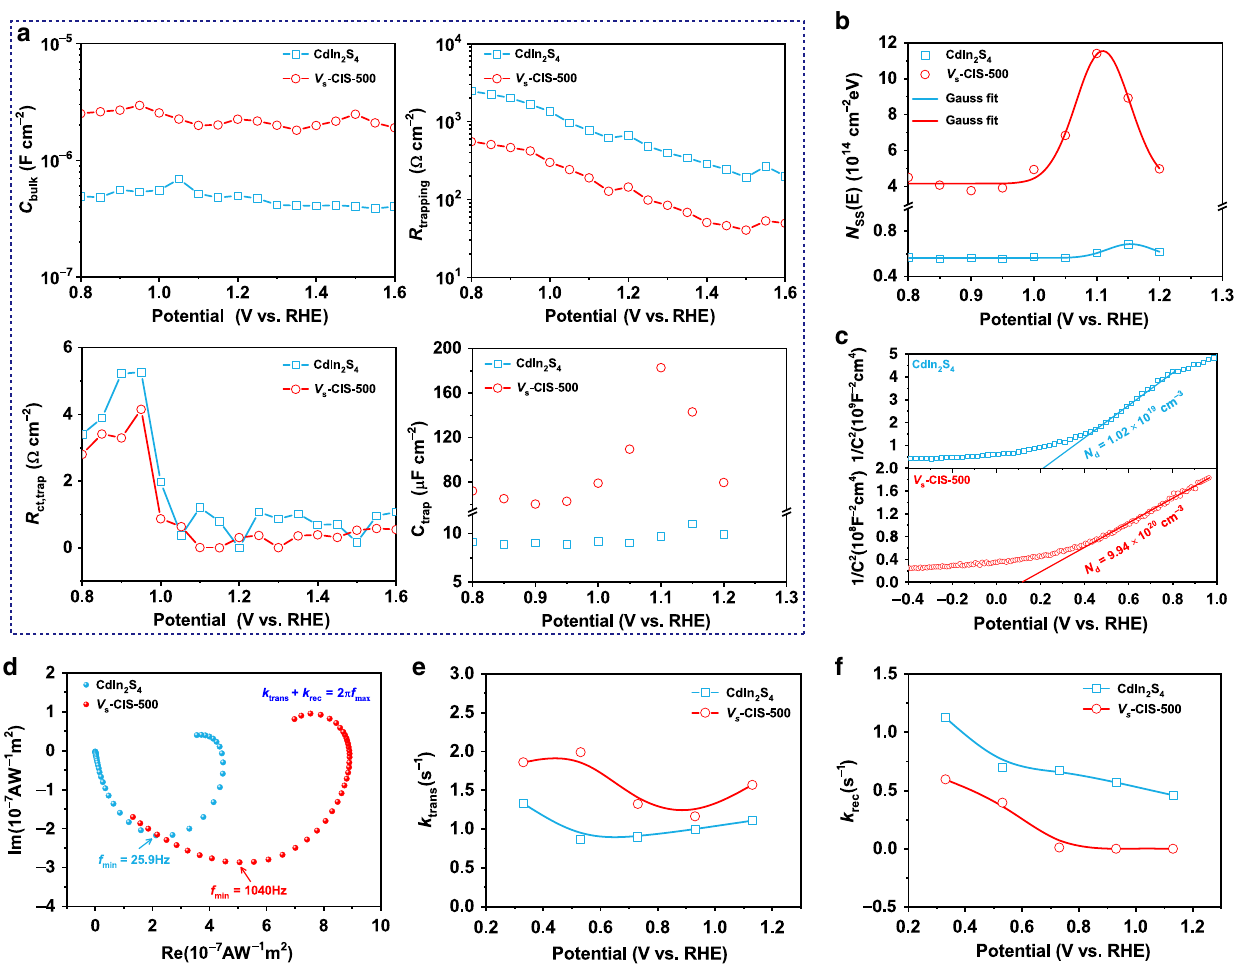
Fig. 4 Charge transfer and recombination kinetics. a Capacitances and resistances parameters associated with the charge trapping ( R trapping , C bulk ) and transfer ( R ct, trap , C trap ) at/from surface states with different applied potentials that are determined from the EIS spectra. Among others, the R s is de fi ned as the series resistance in the PEC cell, C bulk represents the capacitance of charge accumulation in the space charge layer, R trapping represents the resistance of holes trapping at the surface states, R ct, bulk represents the resistance of holes directly transferred from valence band to conduction band, R ct, trap represents the resistance of charge transfer from the surface states to the solution, and C trap represents the capacitance associated with charge accumulation on the surface states. b DOS of surface states (SS) as a function of applied potential for CdIn 2 S 4 and V s -CIS-500 photoanode derived from the C trap . The lines are fi tted by a Gaussian model. c Mott – Schottky plots. d IMPS spectra of the CdIn V 2 S 4 and s -CIS-500 photoanodes under the applied bias of 1.13 V. e The plot of the rate constant of charge transfer vs. potential. f The plot of the rate constant of charge recombination vs.